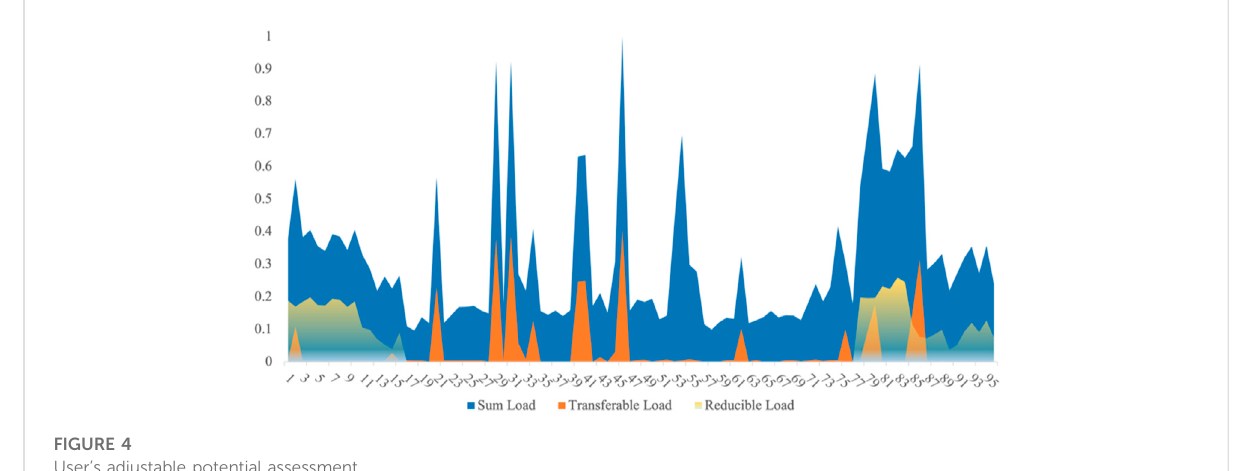
FIGURE 4 User ’ s adjustable potential assessment.